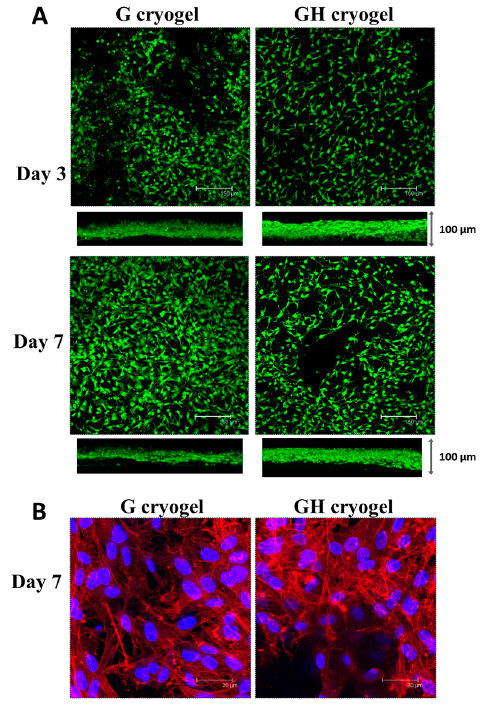
Figure 5. Confocal microscopy observation of mesothelial cells cultured in G and GH by live / dead ( A ) (bar = 150 µ m) and nucleus / cytoskeleton staining ( B ) (bar = 30 µ m). The live cells were stained green and the dead cells were stained red in ( A ), while the cell nuclei were stained blue by Hoechst 33342 and the actin cytoskeleton was stained red by rhodamine-phalloidin in ( B ). Both the merged top-view image and cross-sectional-view image are included in ( A ).